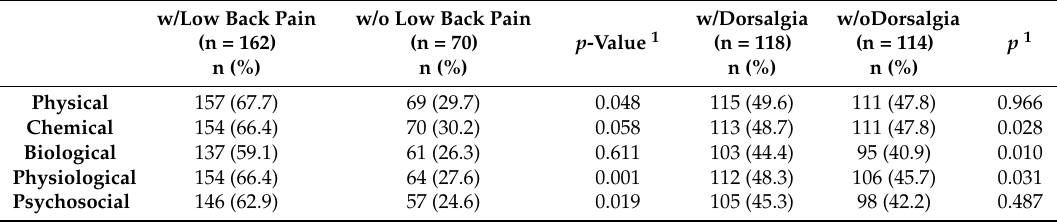
Table 5. Occupational risks (n =